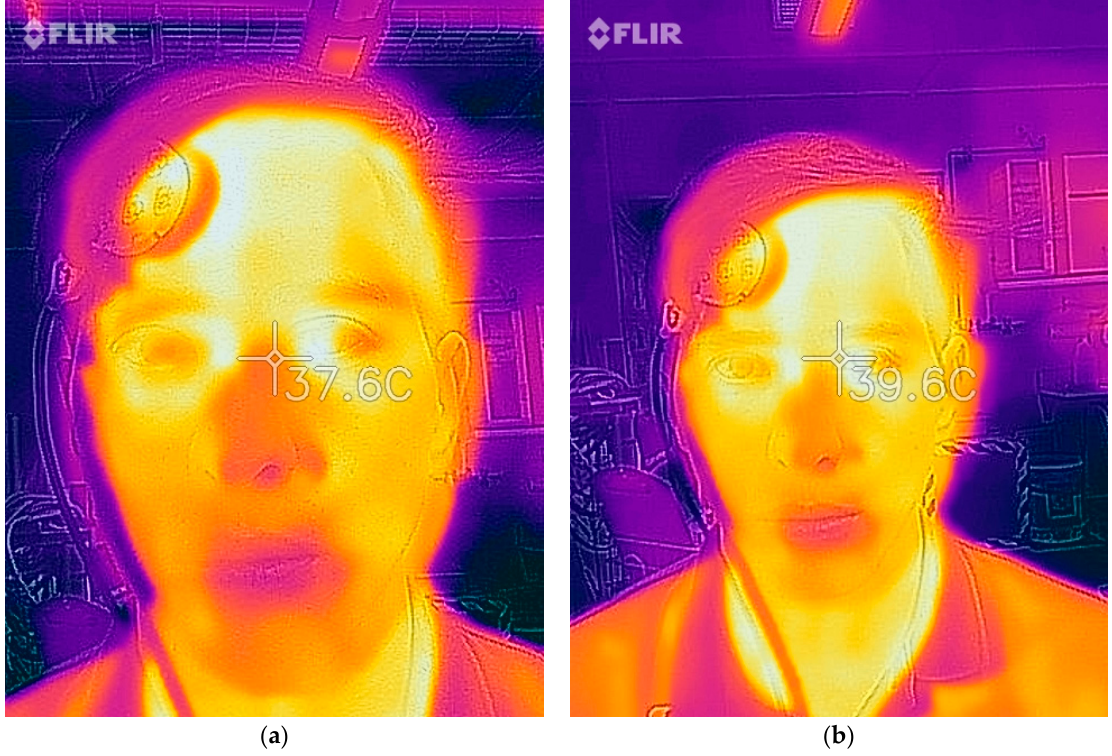
Figure 6. FLIR One Thermal Imaging Camera from 10 cm ( a ) and 50 cm ( b ).